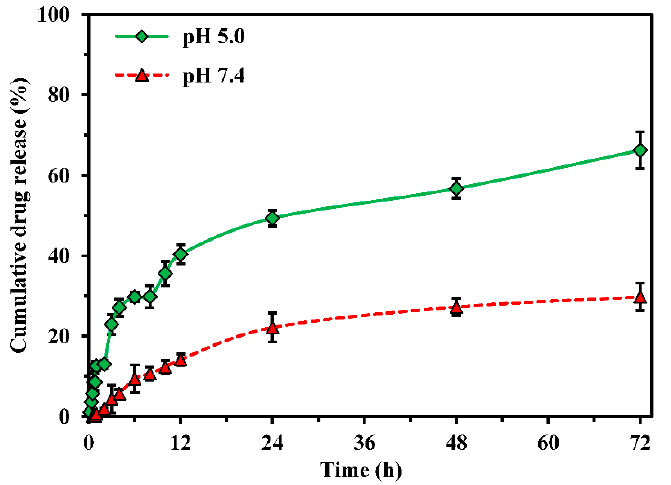
Figure 8. In vitro release profiles of CPT-GNHs@FHQ-PUL in PBS at pH 7.4 and in acetate buffer at pH